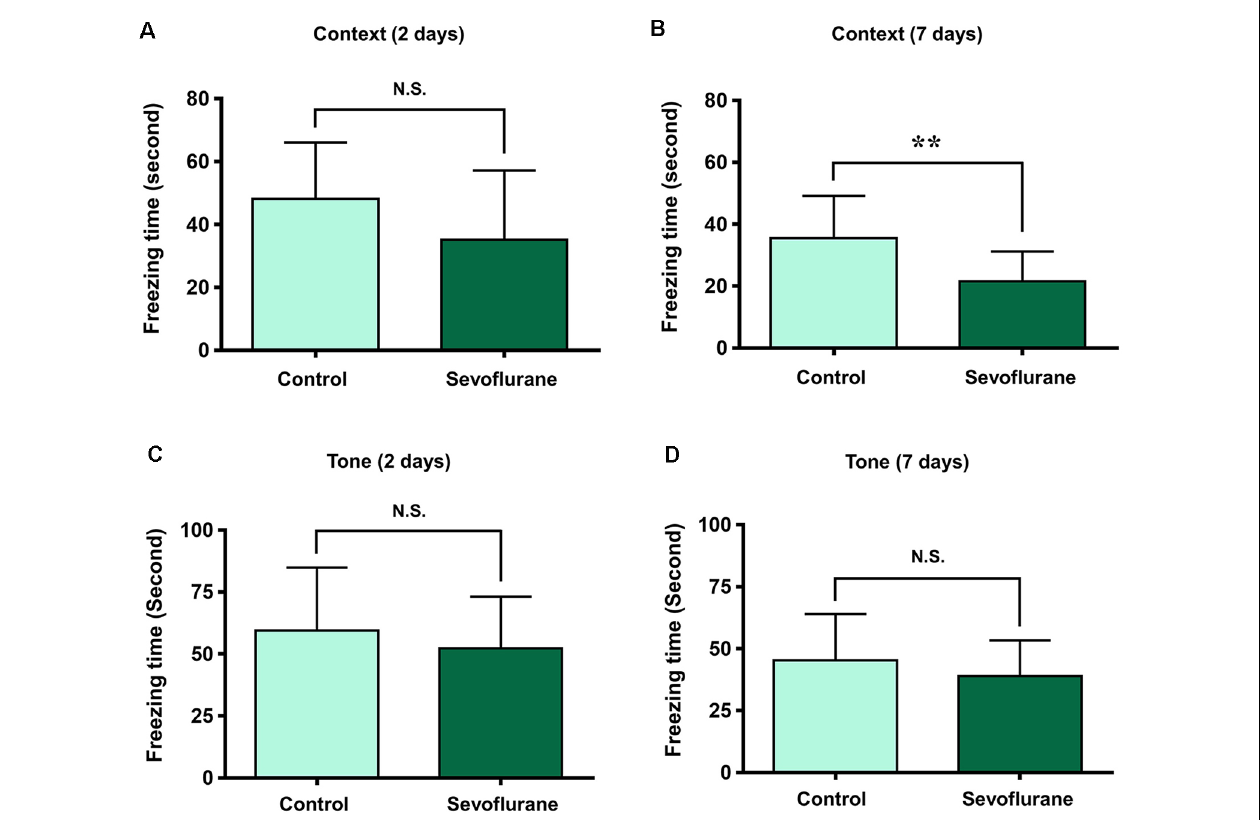
FIGURE 10 | Fear conditioning test (FCT) consisted of a training process at 3 h after anesthesia and evaluations at 2 days and 7 days after anesthesia. The freezing time decreased significantly at 7 days (B) , but not 2 days (A) after anesthesia in the context test. During the tone test, the freezing time did not decrease significantly at 2 days (C) or 7 days (D) after anesthesia. ** p < 0.01 and N.S.: Not